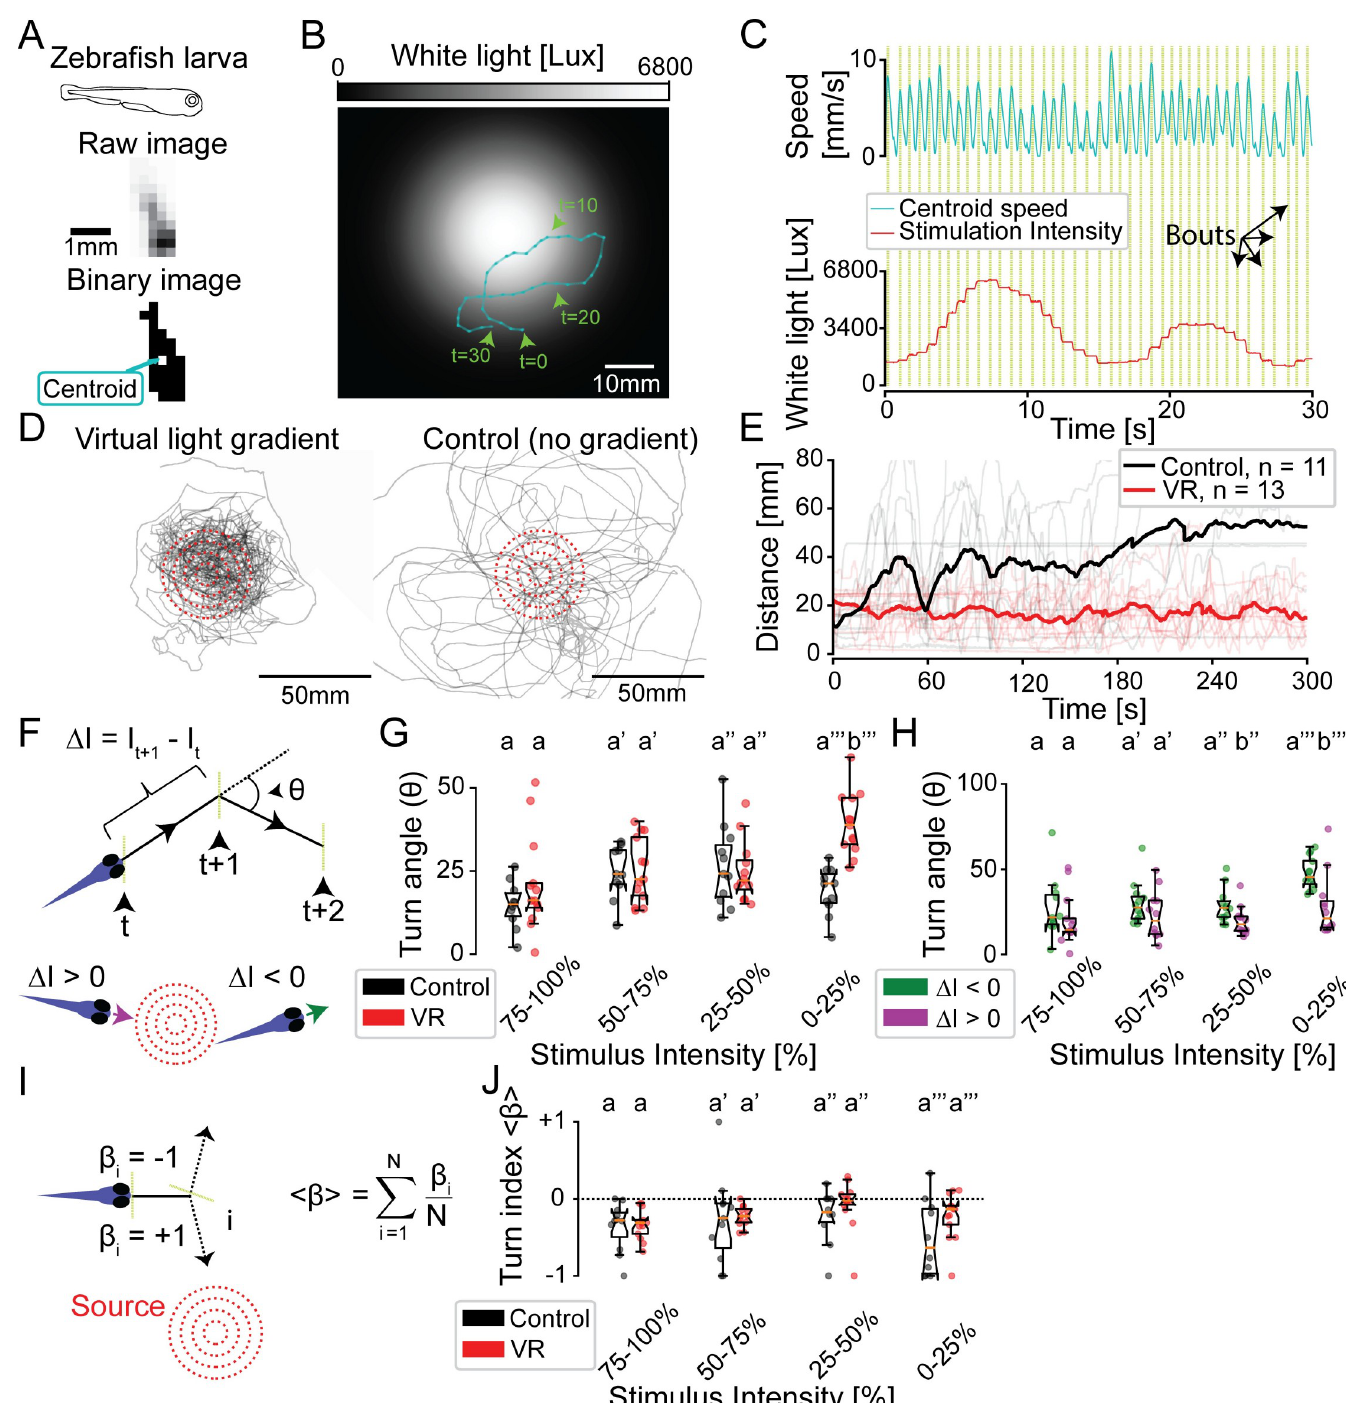
Fig 4. Zebrafish larvae adapt their turn dynamics to stay close to a virtual-light source. (A) Illustration of the identification of a moving zebrafish larva by PiVR. (B) Illustrative trajectory of a zebrafish larva in a virtual-light gradient having a Gaussian geometry. Panel C displays the time course of the speed and the white-light intensity during that trajectory shown in panel B. Yellow vertical lines indicate automatically detected bouts. (D) Trajectories of 13 fish tested in virtual-light gradient (left) and 11 fish in control (right). Red circles indicate 10-, 20-, 30-, and 40-mm distances to the center of the virtual-light source (see Methods). (E) Thick lines indicate the time courses of the median distances to the virtual-light source. The light lines indicate individual trials. (F) Illustration of the discretization of a trajectory segment into bouts: yellow vertical lines indicate the position at which the animal stops, reorients, and starts the next bout. Black dashed lines indicate movement of the fish. The turn angle ( θ ) and change in light intensity ( Δ I) are calculated for every pair of consecutive bouts (see Methods). The bottom of panel F illustrates a swim bout oriented